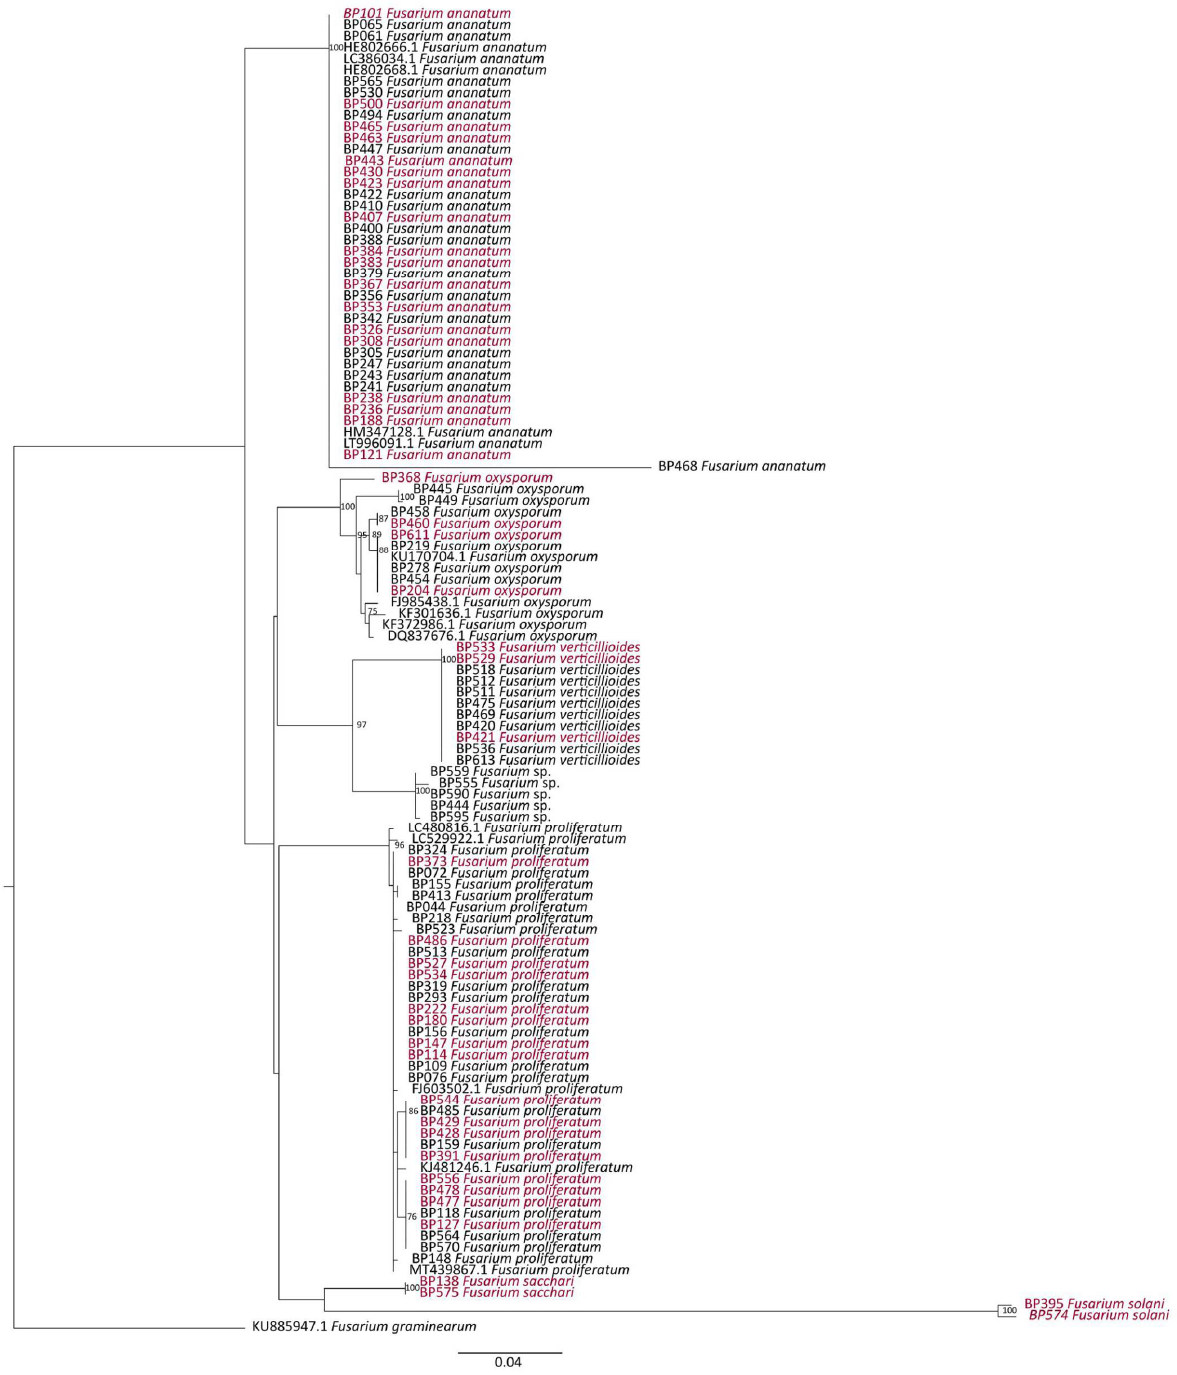
Figure 7. Phylogenetic tree of Fusarium species computed by Maximum Likelihood (ML) analysis (TIM2ef+G as the best fit model) and based on a TEF-1α sequences dataset. Only ML bootstrap branches that support values greater than 70% are shown. Strains isolated from infected (IF) and healthy fruitlets (HF) are indicated in red and black, respectively. The tree is rooted with F. graminearum accession KU885947.1.